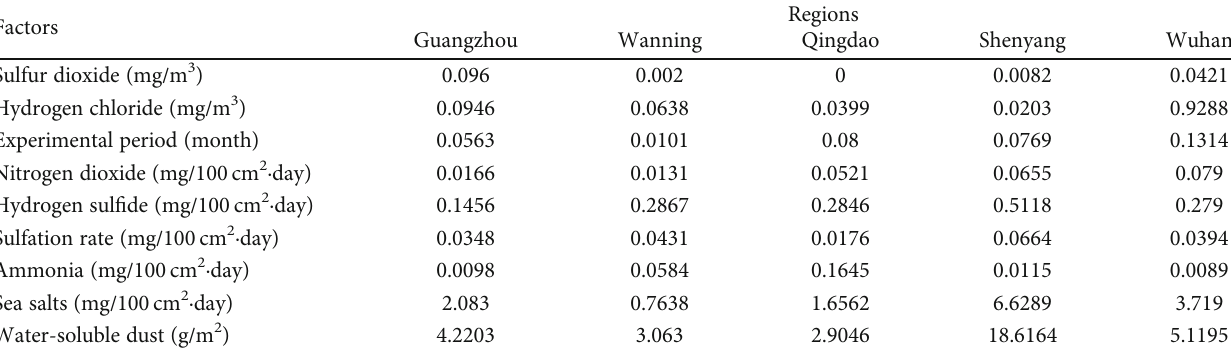
Table 3: Median values of the pollutant factors in the well data-accumulated regions.